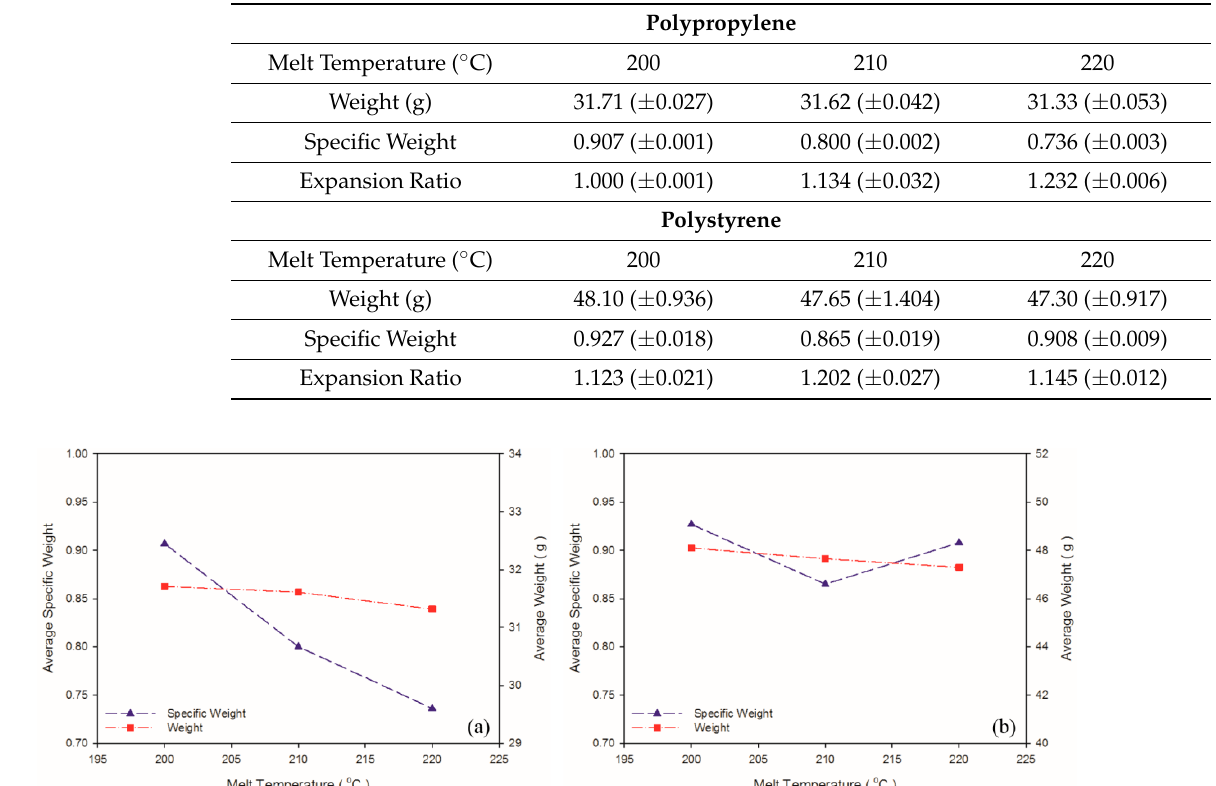
Figure 9. Weight and specific weight at different melt temperatures: ( a ) PP matrix and AC CBA; ( b ) PS matrix and AC CBA.